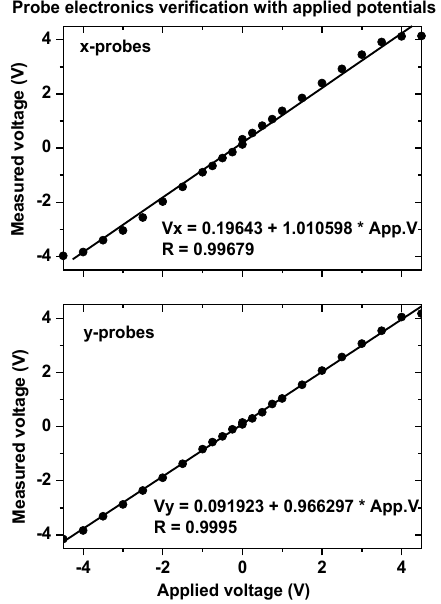
Figure 4. Performance results for the probe–electrometer system obtained just prior to launch. Known voltages are applied to the x and y probes separately in isolation and the electrometer outputs monitored on the respective telemetry channels. The equation for the linear regression line and the correlation coefficient ( R ) are men- tioned separately in each plot.